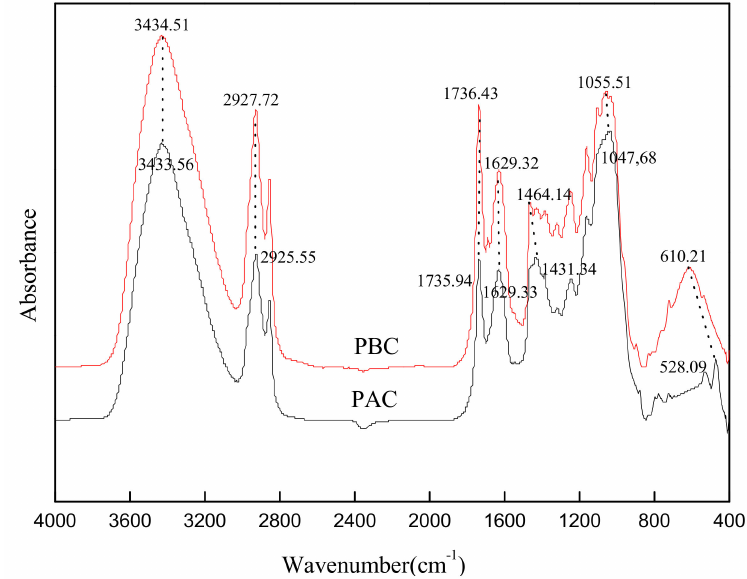
Figure 3. FTIR spectra of adaxial (PAC) and abaxial (PBC) cuticle of Photinia serrulata